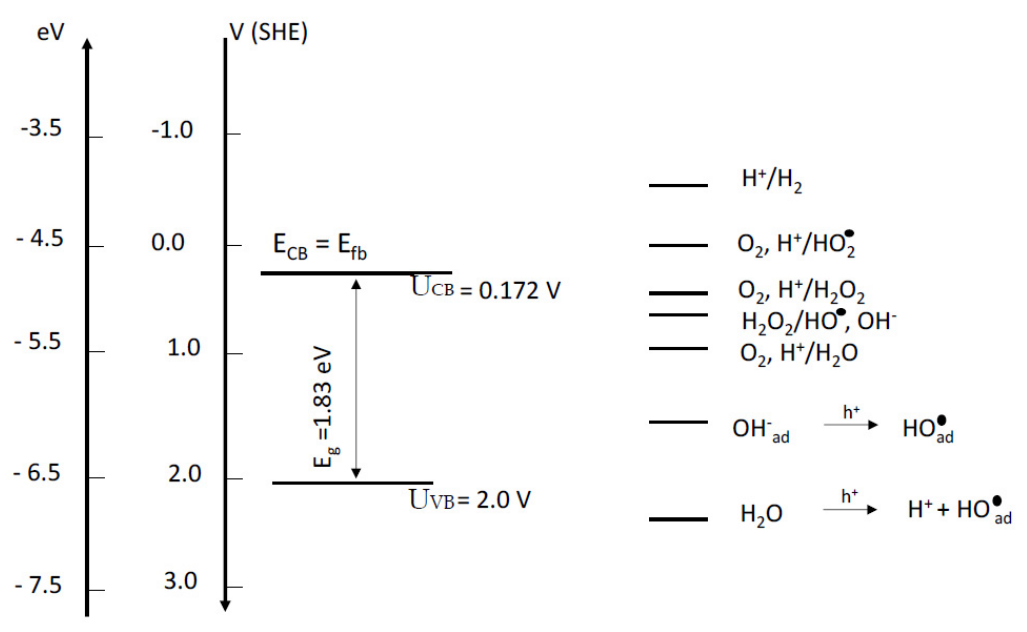
Figure 10. Schematic diagram of energy/potential diagram of maghemite nanoparticles and redox potential reactions of the photocatalytic degradation of tetracycline, pH 7.